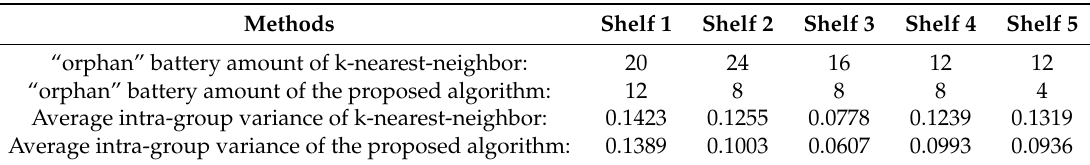
Table 2. Comparison between the proposed method and the original k-nearest-neighbor algorithm.